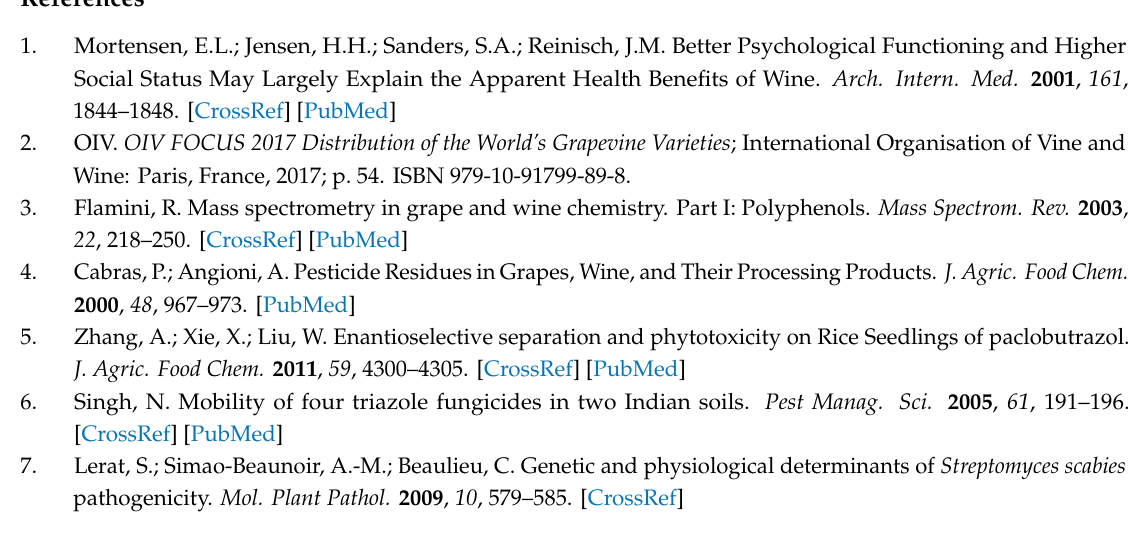
Supplementary Materials: The supplementary materials are available online, Figure S1: Structure of triadimefon of wine; Figure S3: PCA (Principal Component Analysis) diagram of all samples; Figure S4: Venn diagram of the common volatile components in the four wine samples. Table S1: Electronic nose principal component analysis table; Table S2: Taste di ff erences of